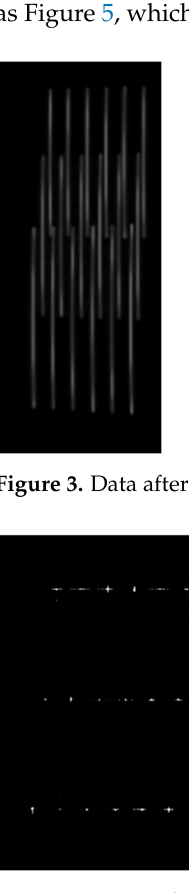
Figure 4. Image after focused imaging.